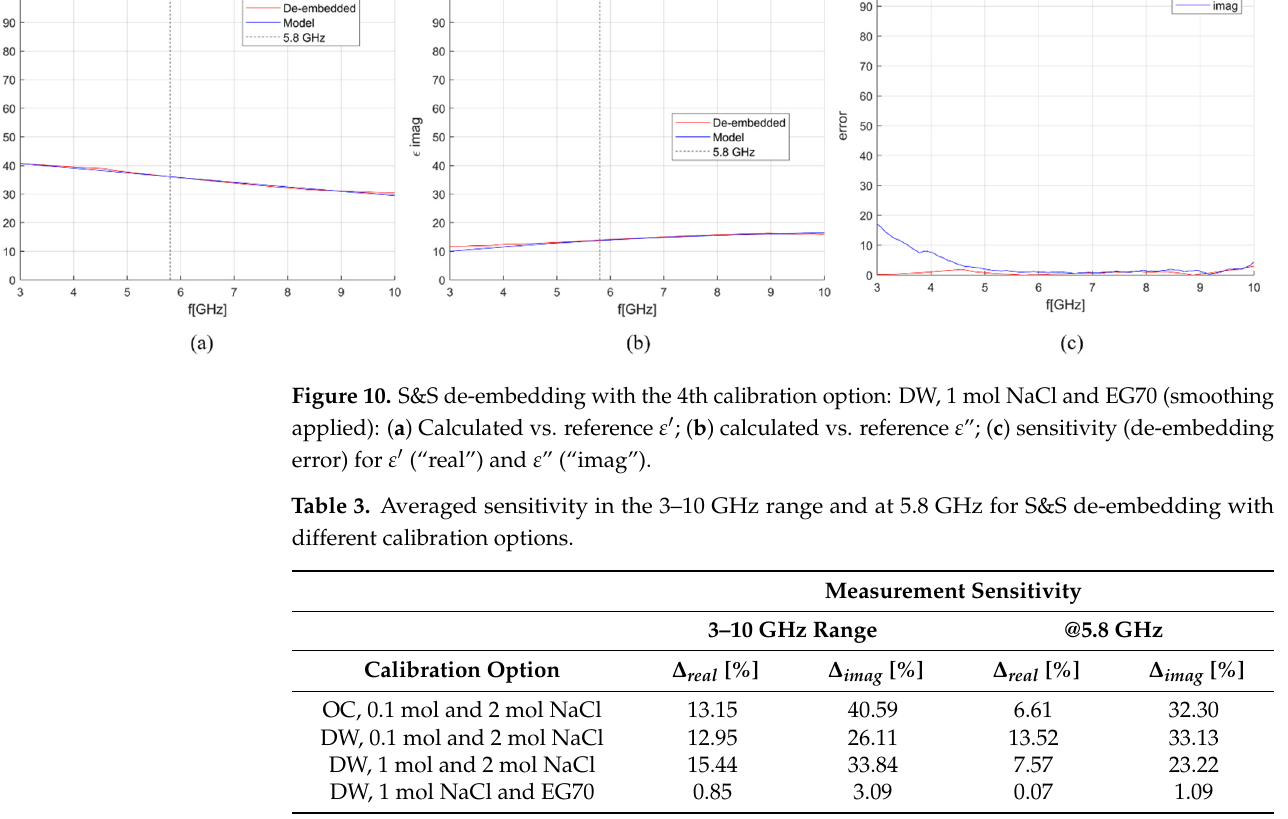
Table 3. Averaged sensitivity in the 3–10 GHz range and at 5.8 GHz for S&S de-embedding with different calibration options.